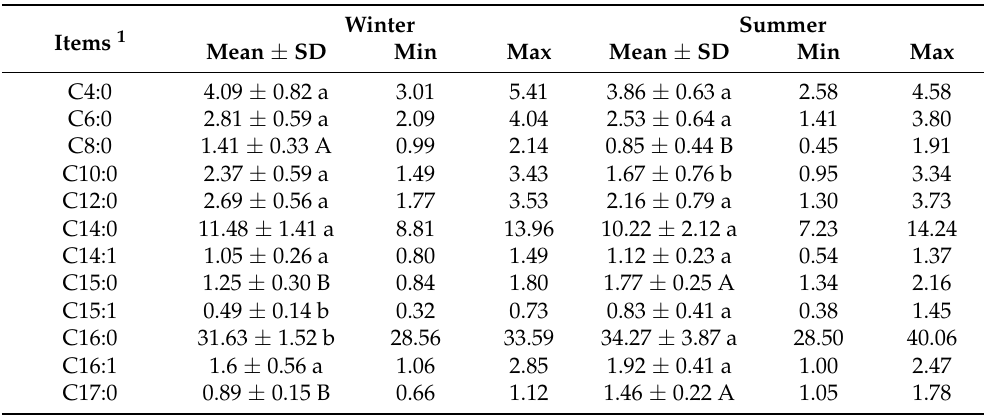
Table 3. Mean (g/100 g of fatty acids) ± SD and range of individual fatty acids of crossbred buffalo raw milk in winter and